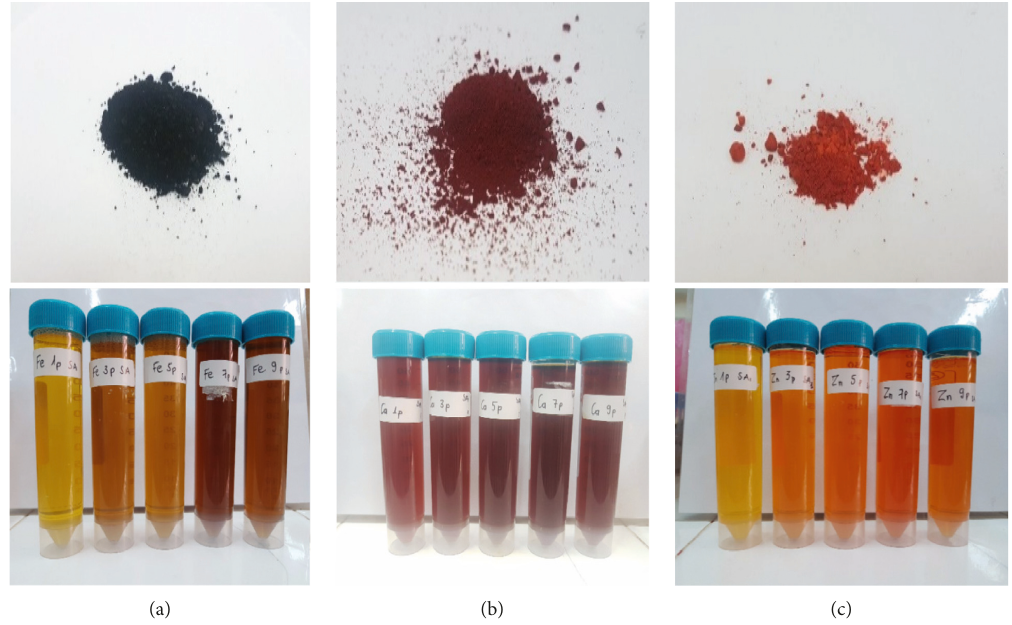
Figure 2: The complexes of curcumin-metal ion (above solid, under solution): (a) curcumin-Fe(III), (b) curcumin-Ca(II), and (c)